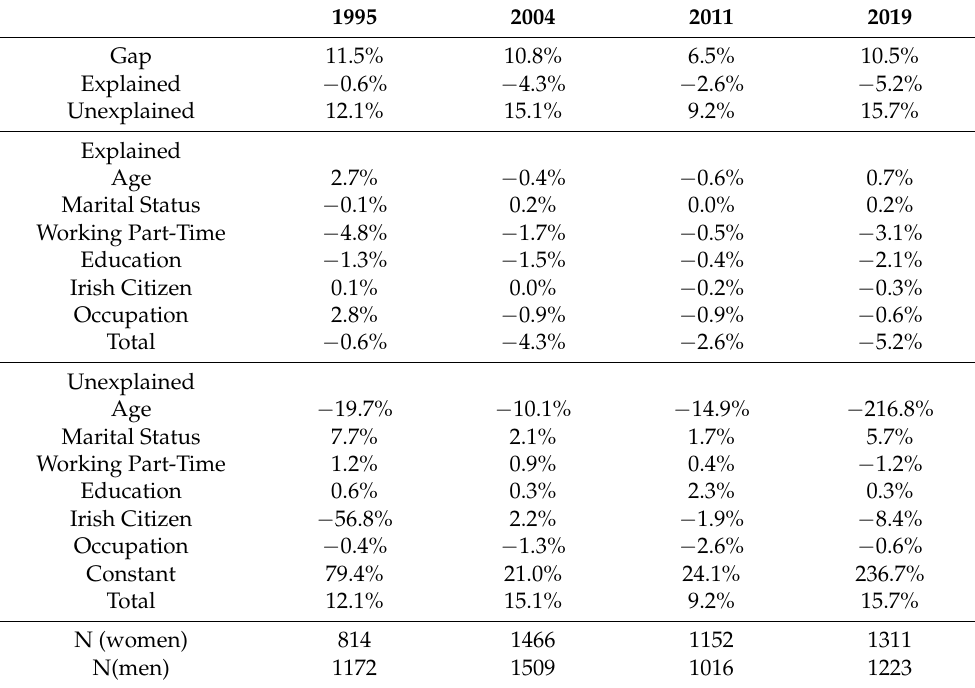
Table A9. Detailed decomposition results from RIF regressions for selected years at the 90th